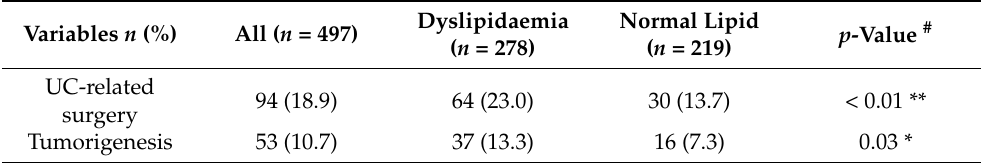
Dyslipidaemia Normal Lipid ( n = 278)